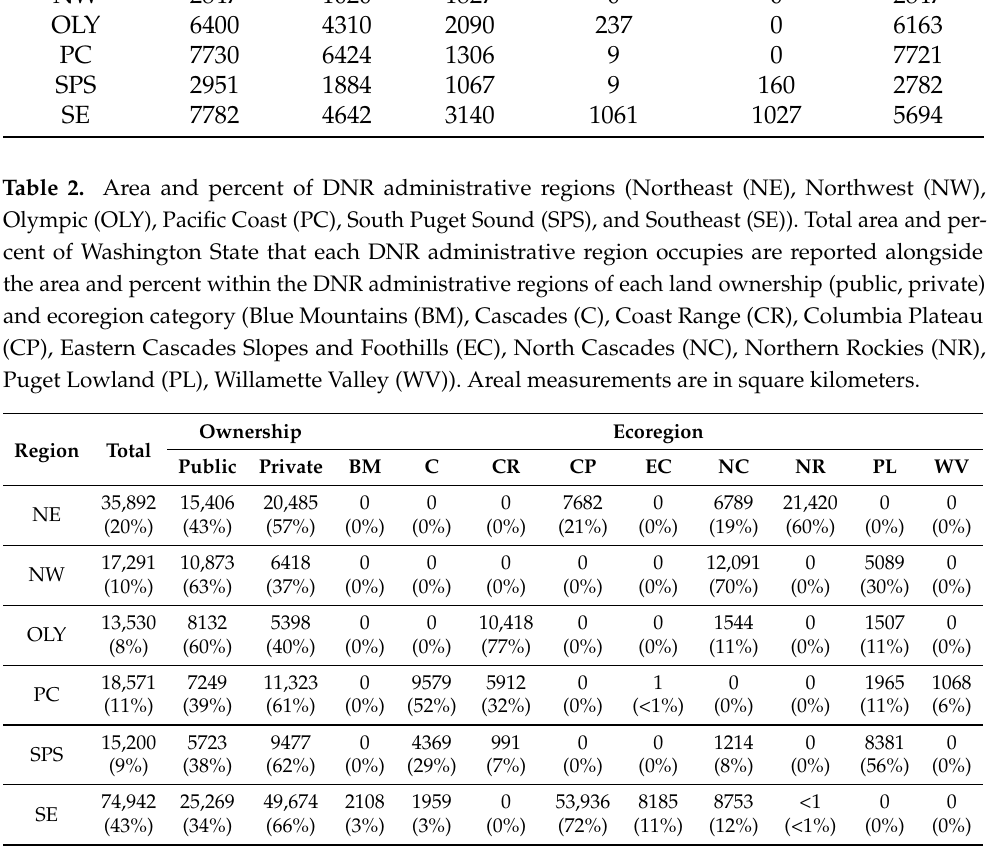
Table 1. Number of burn requests between 2004 and 2019, disaggregated by approval outcome and burn category for each DNR administrative region (Northeast (NE), Northwest (NW), Olympic (OLY), Pacific Coast (PC), South Puget Sound (SPS), and Southeast (SE)). Approved Category Region Total